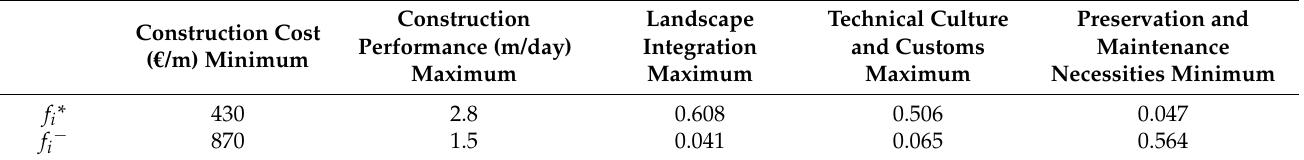
Table 4. Values f i * and f i − , applicating step 1 of the viekriterijumsko kompromisno rangiranje (VIKOR) method Source: the authors’ own